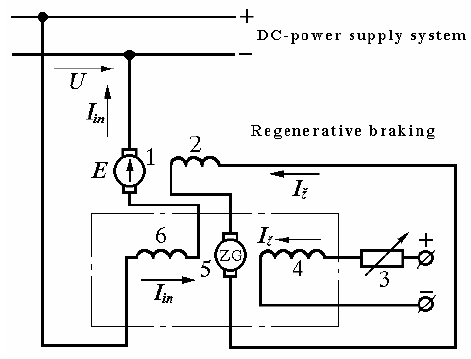
Fig 4. The connection of traction motor and special excitation generator during regenerative braking: 1 – traction motor; 2 – traction motor’s excitation winding; 3 – controlled resistor; 4, 6 – excitation windings with oppositely directed magnetomotive forces of DC mixed excitation generator (see current direction of windings 4 and 6 in Fig 4); 5 – excitation I – armature (regenerative) current of traction generator; in